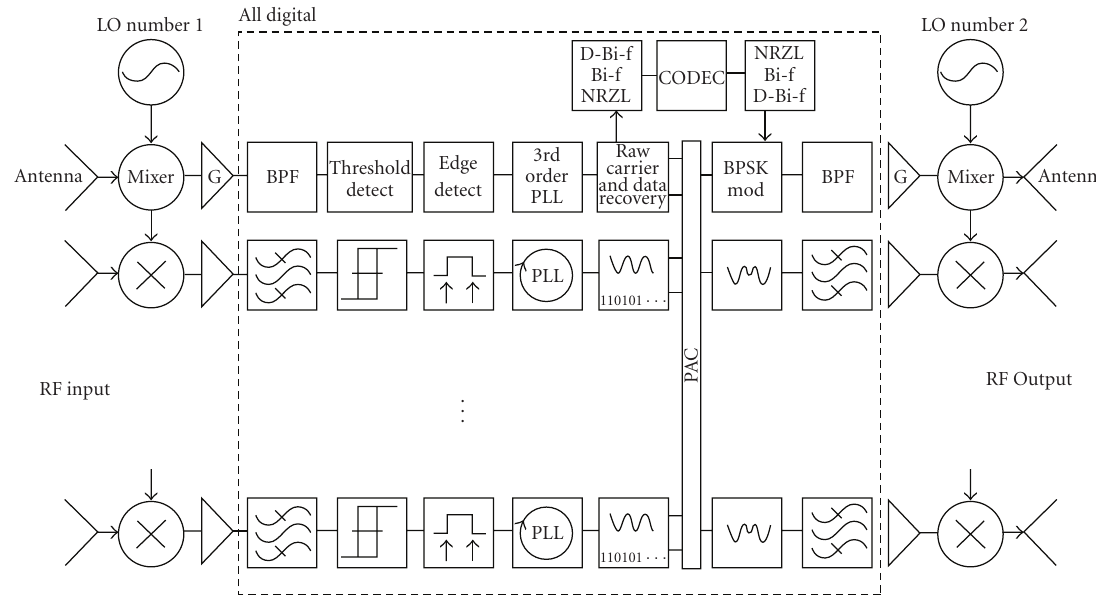
Figure 12: Schematic of a digital retrodirective